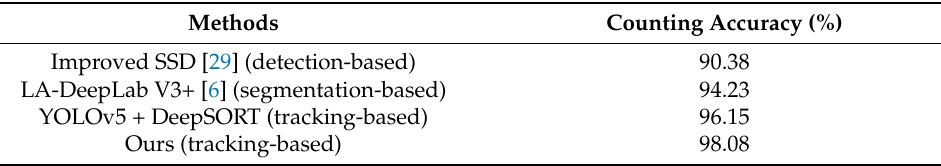
Table 5. Comparison of several animal counting